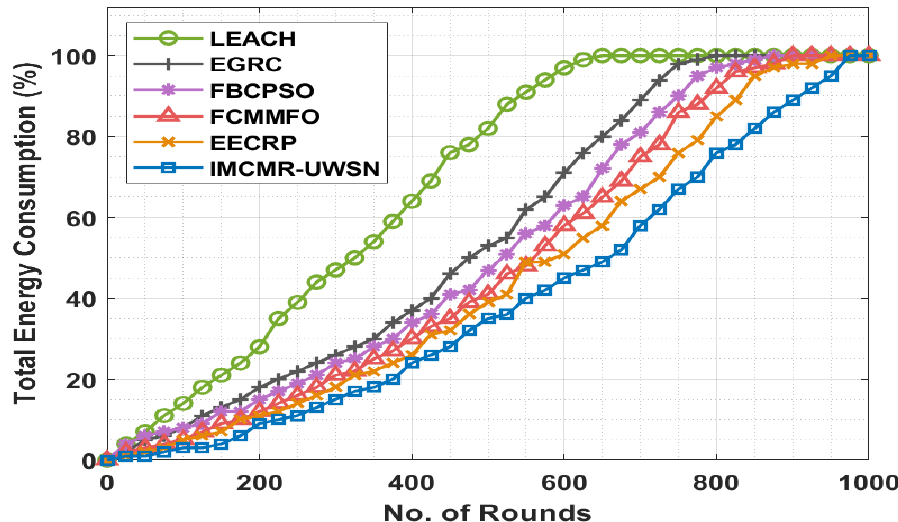
Figure 6. TEC analysis of the IMCMR-UWSN technique.